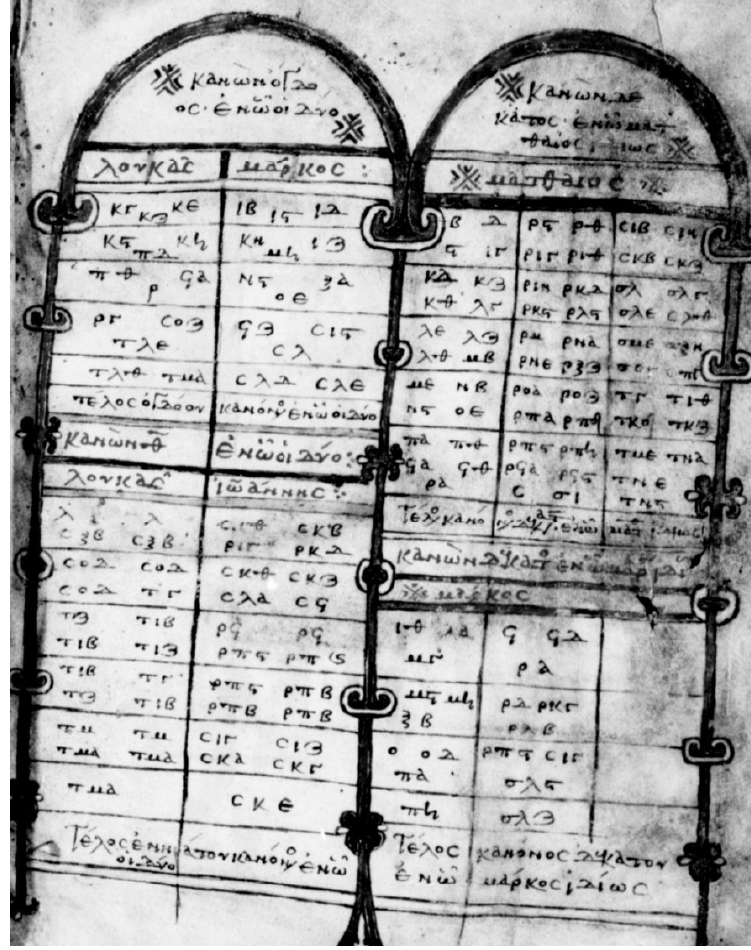
Figure 1. GA 1230 folio 4 r . It shows sections 234–235 of the Long Ending in canon 8 (fifth row, top left), whereas sections 236–237 are in canon 10 (second column, third and fourth rows, bottom right). Copyrights: Library of Congress Collection of Manuscripts in St. Catherine’s Monastery, Mt.